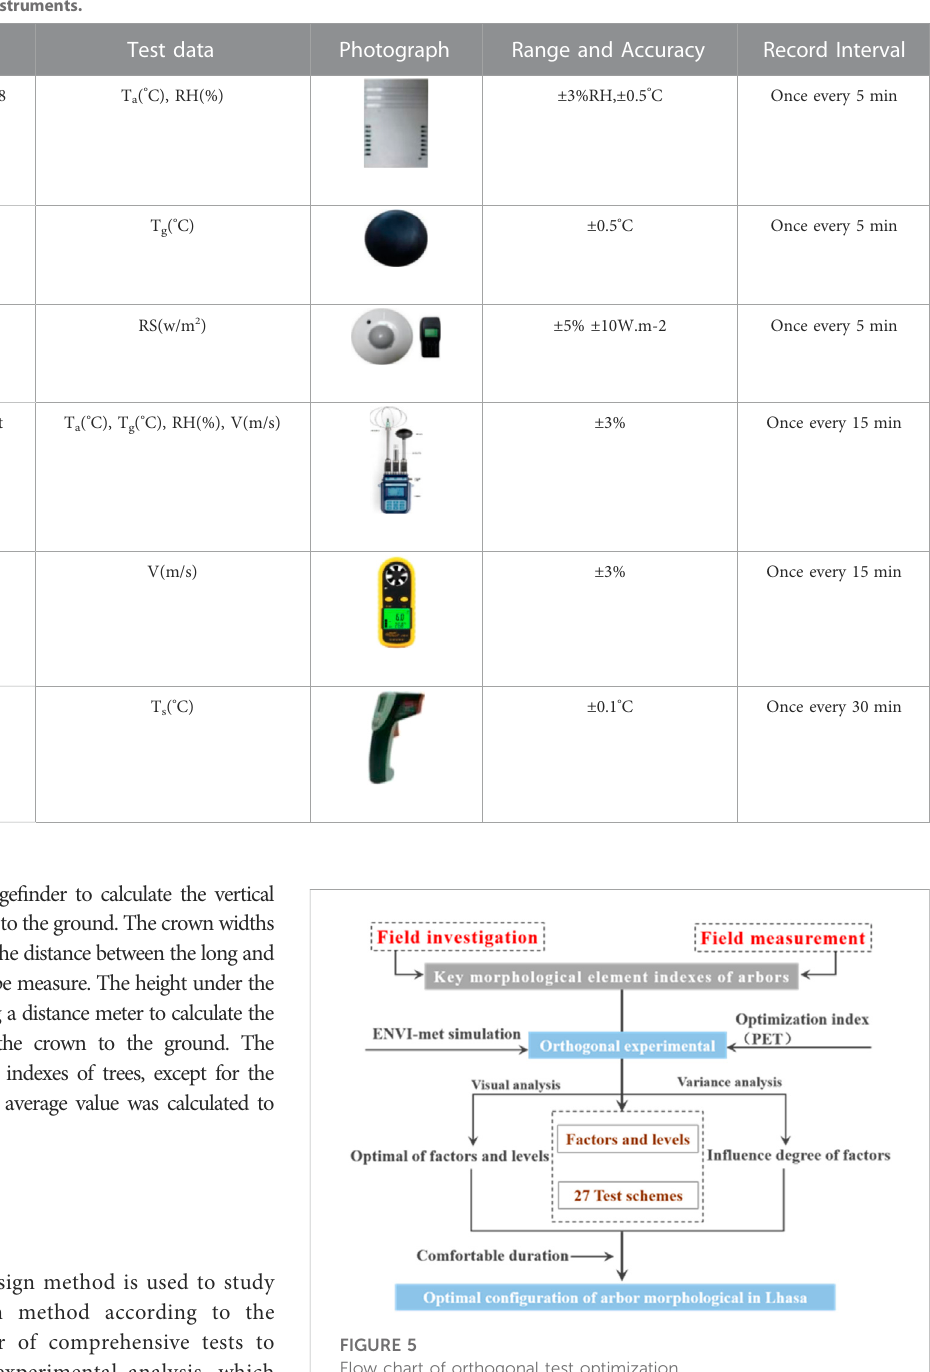
FIGURE 5 Flow chart of orthogonal test